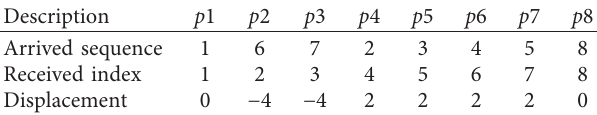
Table 1: Example of out-of-order for eight-packet sequence. Description